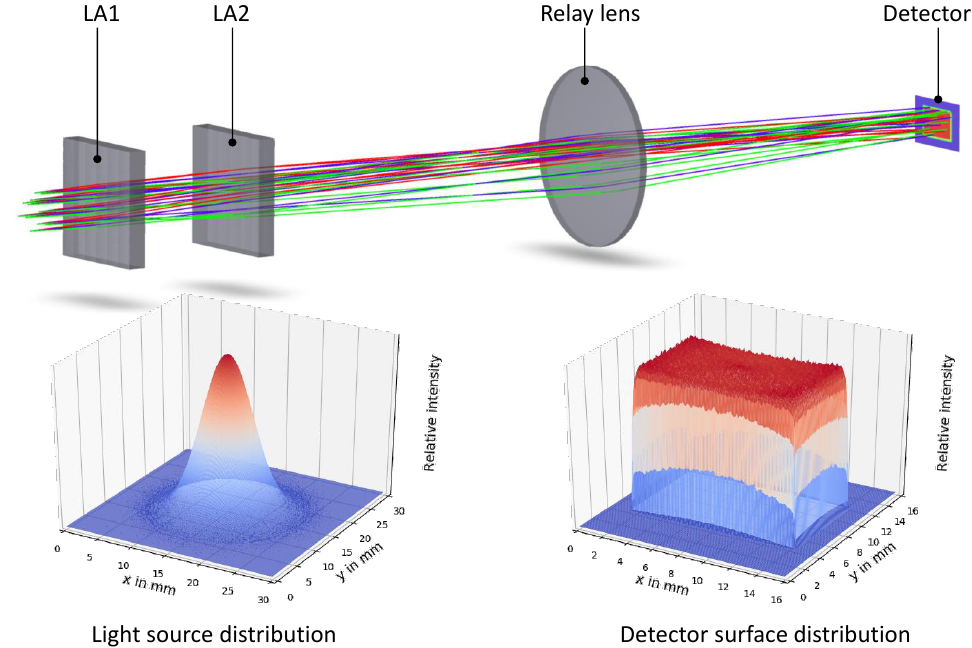
Figure 5. Simulation model of a LA homogenizer with the distibutions of the radiation intensity of the incident light and the target